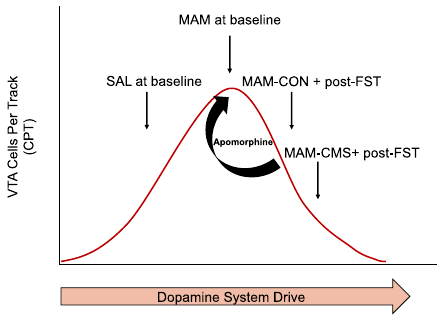
Fig. 5 Apomorphine reverses putative FST-induced depolariza- tion block of DA neurons in MAM rats. a Post-FST, MAM-CMS